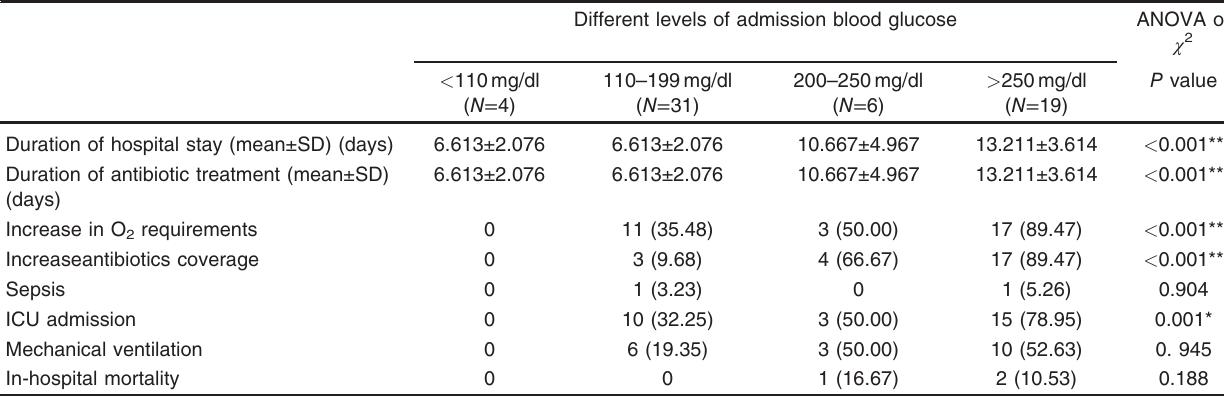
Table 5 Comparison between different levels of admission blood glucose and community-acquired pneumonia patients ’